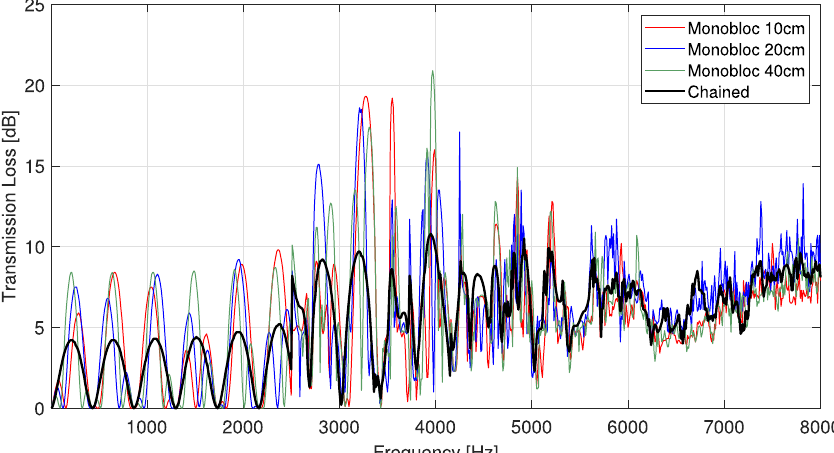
Figure 8. Transmission loss due to the association of two rigid expansion chambers (note the power fl ow model is constructed using equal energy per